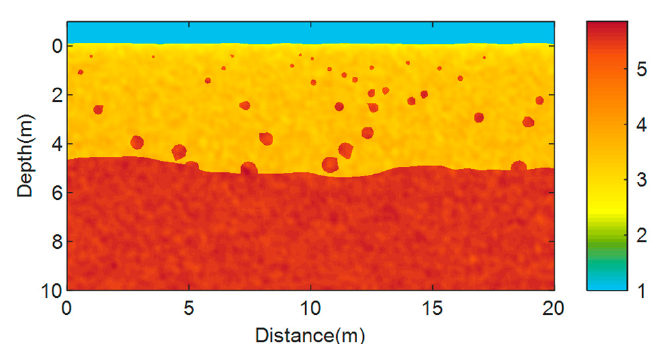
Figure 9. The integrated relative permittivity model of lunar regolith [27,35].